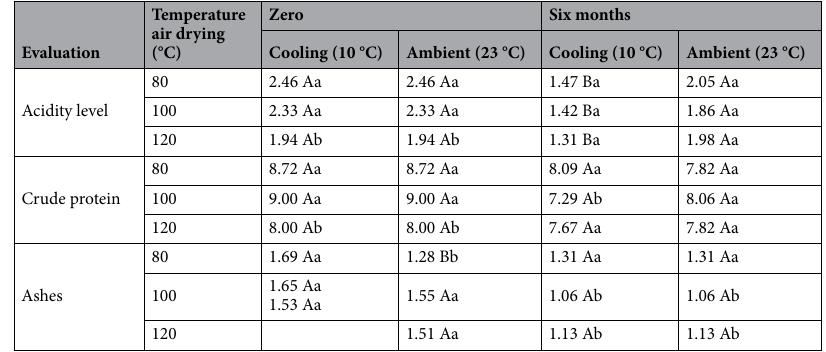
Table 5. Average results of 0.1 N NaOH acidity index (mL), crude protein (%), and ash (%) of corn kernels as a function of drying air temperature, condition and storage time. Averages followed by the capital letter on the line, for each storage time and lower case letters in the columns for each drying air temperature, do not differ, at 5%